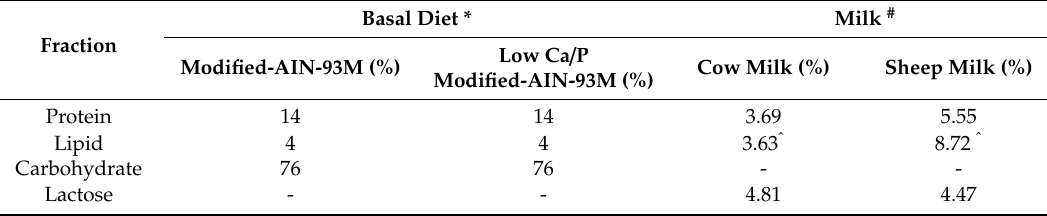
Table 2. Nutritional composition of diets.